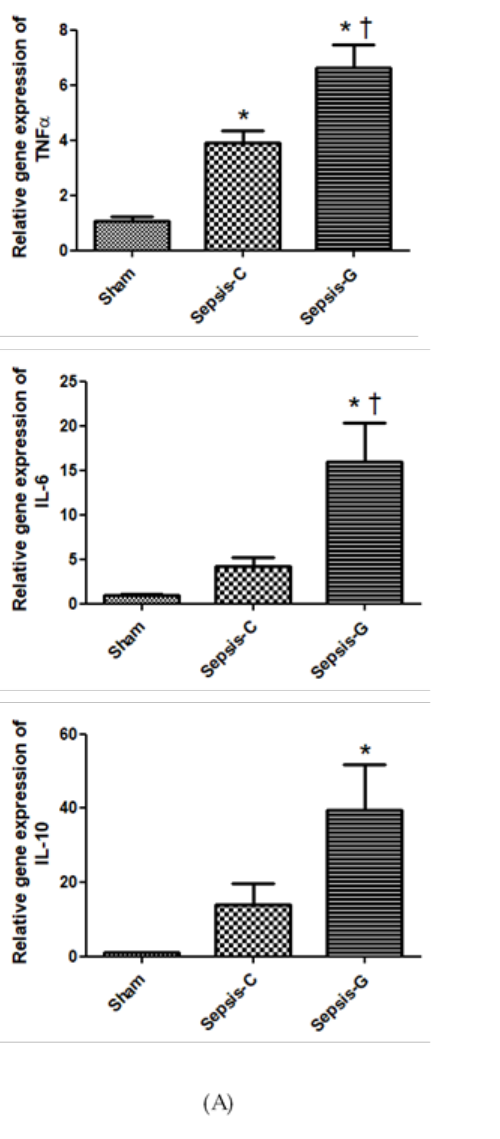
Figure 3. Expressions of tumor necrosis factor (TNF)- α , interleukin (IL)-6 and IL-10 genes in the liver ( A ) 24 and ( B ) 72 h after cecal ligation and puncture (CLP). Sham: control group with a sham operation; Sepsis-C: control group with CLP; Sepsis-G: glutamine (GLN) group with a CLP operation. Quantitation of mRNA changes was analyzed by a real-time PCR and was calculated by the comparative CT (2 − ∆∆ Ct ) method. mRNA expression levels in the sham control group were used as a calibrator. Data are shown as the mean ± SEM. n = 8 for each group. Di ff erences among the sham, Sepsis-C, and Sepsis-G groups were analyzed by a one-way ANOVA with the Bonferroni post-hoc test. * Significantly di ff ers from the sham group. + Significantly di ff ers from the Sepsis-C group ( p < 0.05).